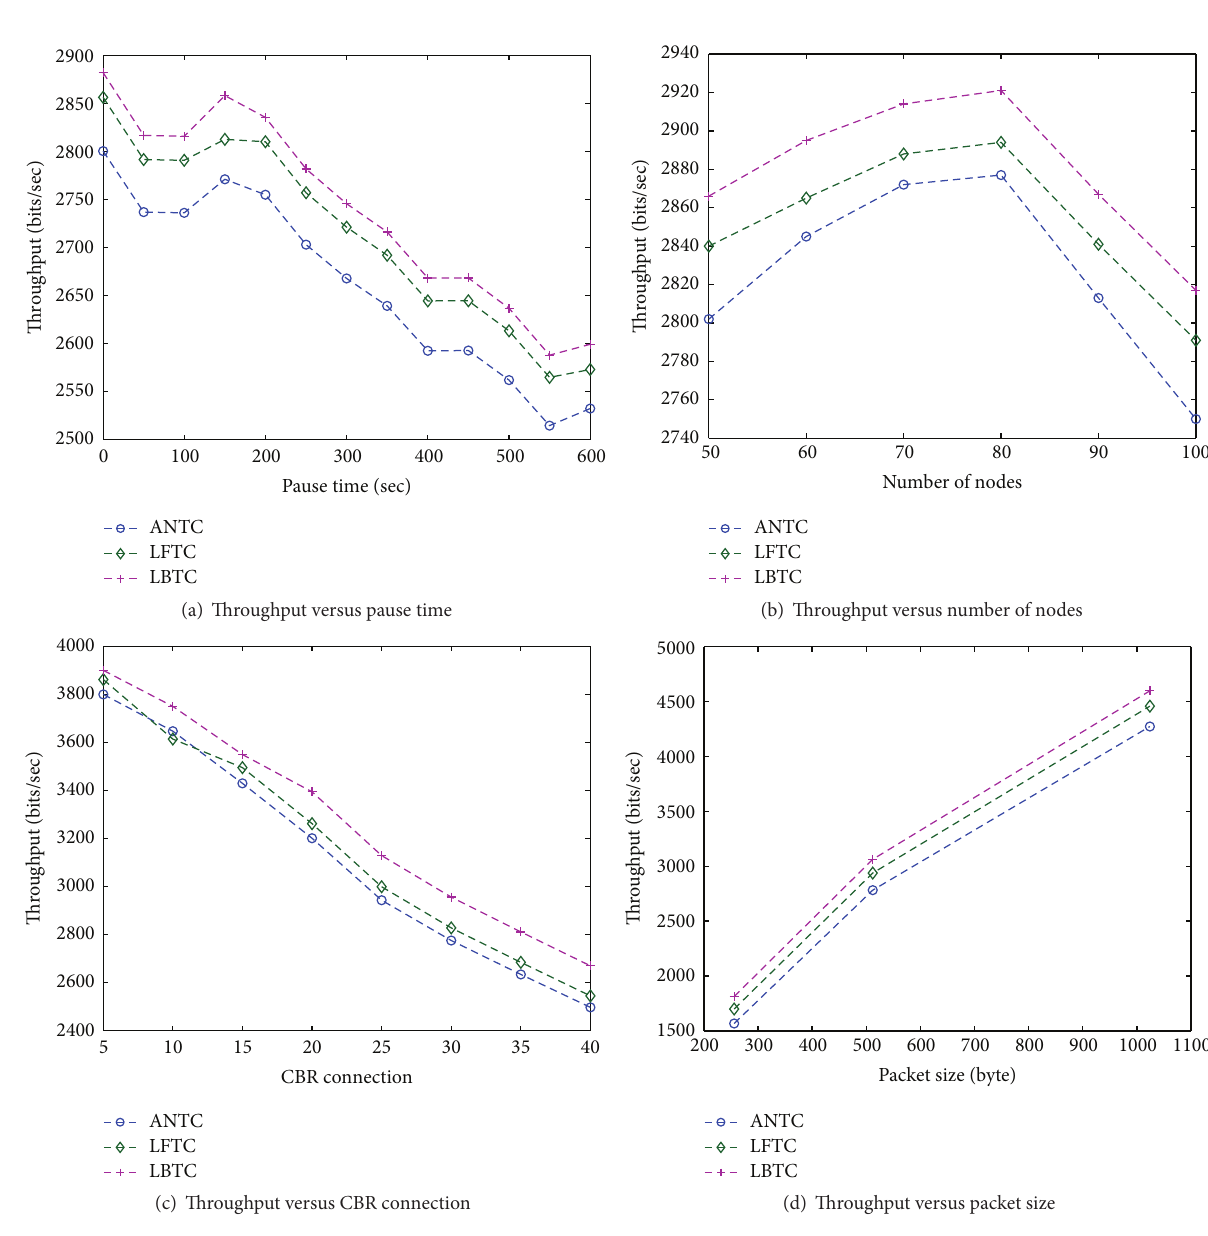
Figure 5: Network